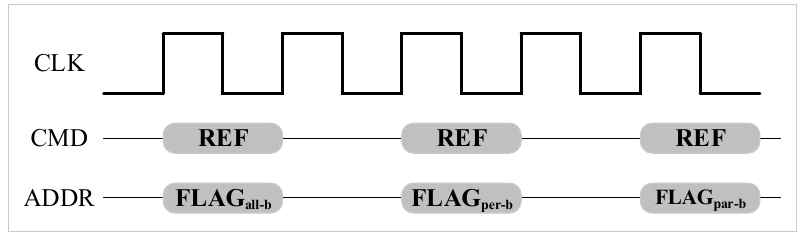
Figure 12. Refresh commands with different flags.